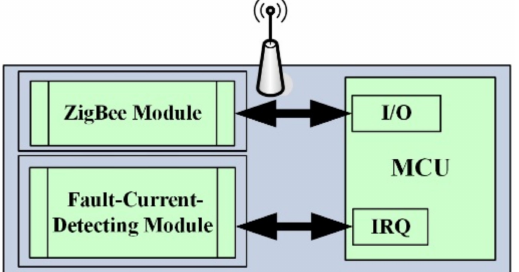
Figure 2. Hardware architecture of the ZigBee-based FCI. MCU: Micro-controller Unit;